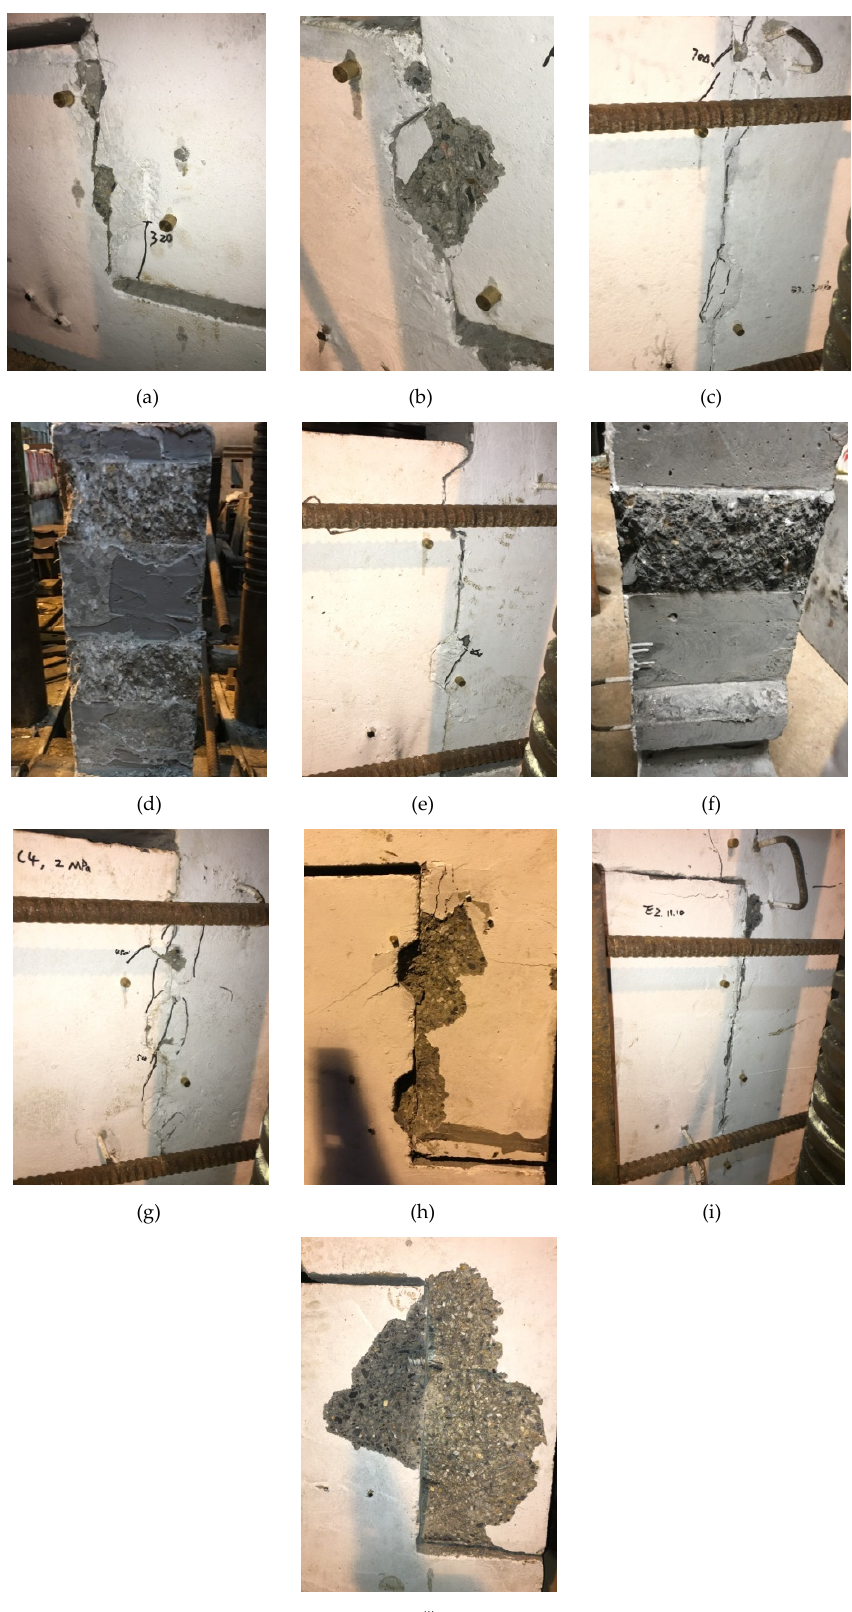
Figure 7. Typical crack patterns of joints during or after the tests: ( a )M0.5-E-K1-N; ( b )M2.0-D-K1-N; ( c ) M3.0-E-K2-N; ( d ) damaged shear plane of M3.0-E-K2-N; ( e ) M1.0-D-K2-N; ( f ) damaged shear plane of M1.0-D-K2-N; ( g ) M2.0-D-K3-N; ( h ) M2.0-D-K2-R; ( i ) M1.0-E-F-R; ( j ) M2.0-D-F-R.